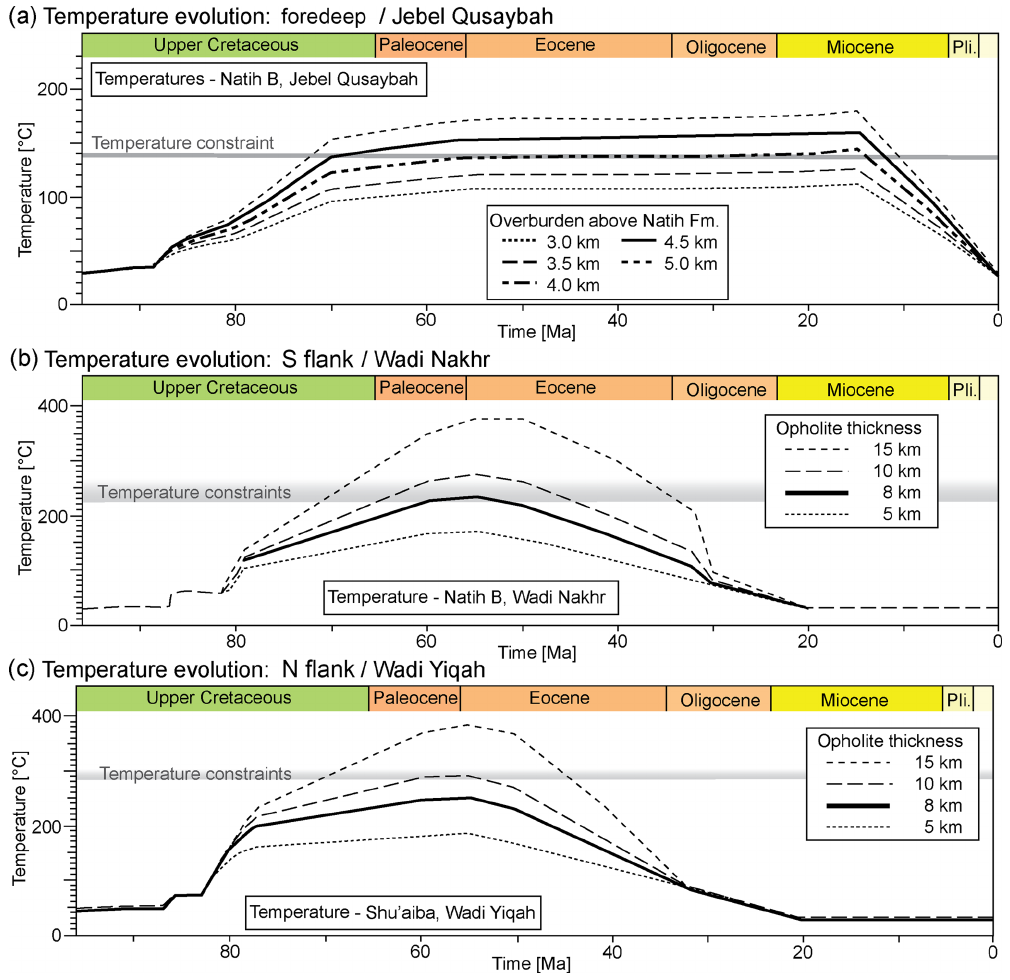
Figure 9. Sensitivity analysis of paleo-overburden and its influences on temperature in comparison to calculated peak temperatures (gray area) for pseudo-wells at Jebel Qusaybah (a) , Wadi Nakhr (b) , and Wadi Yiqah (c)